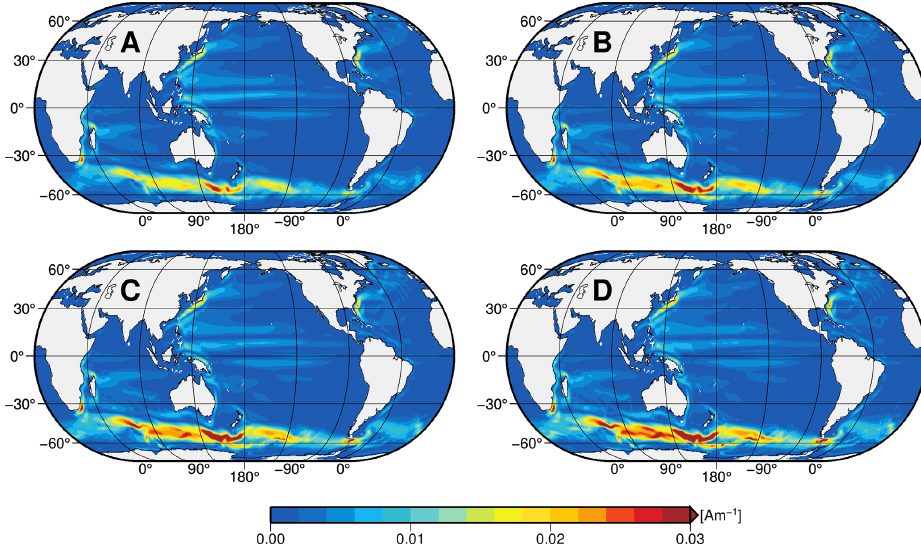
Figure 3. Annual mean values of the upper layer oceanic electric current density j Up for scenarios A, B, C, and D with layer thicknesses of 1050, 1450, 2100, and 3000m,